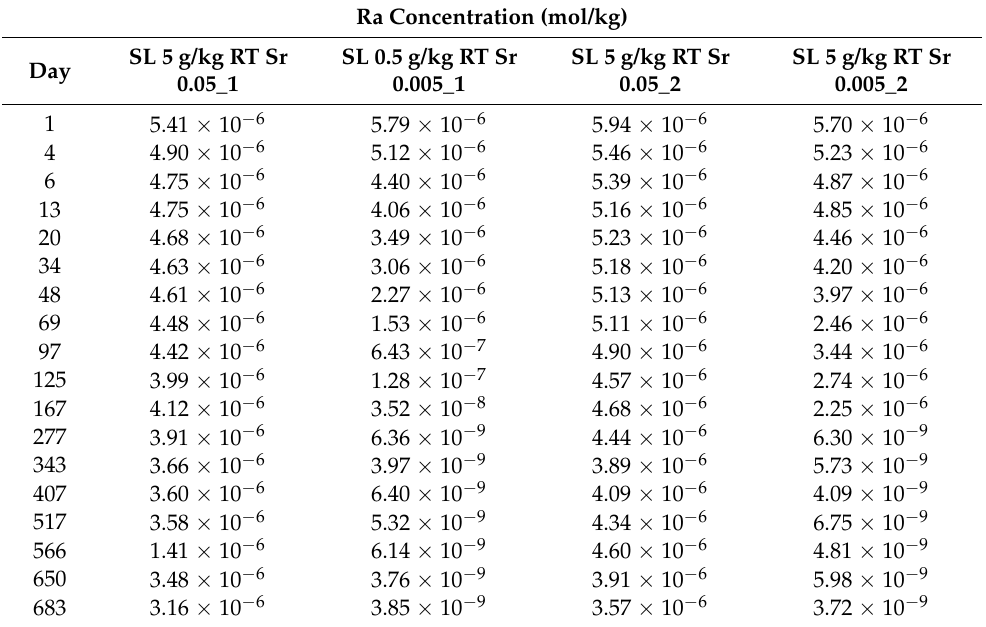
Table A10. Ra concentration of experiments with Sr in the aqueous solution at 23 ◦ C.